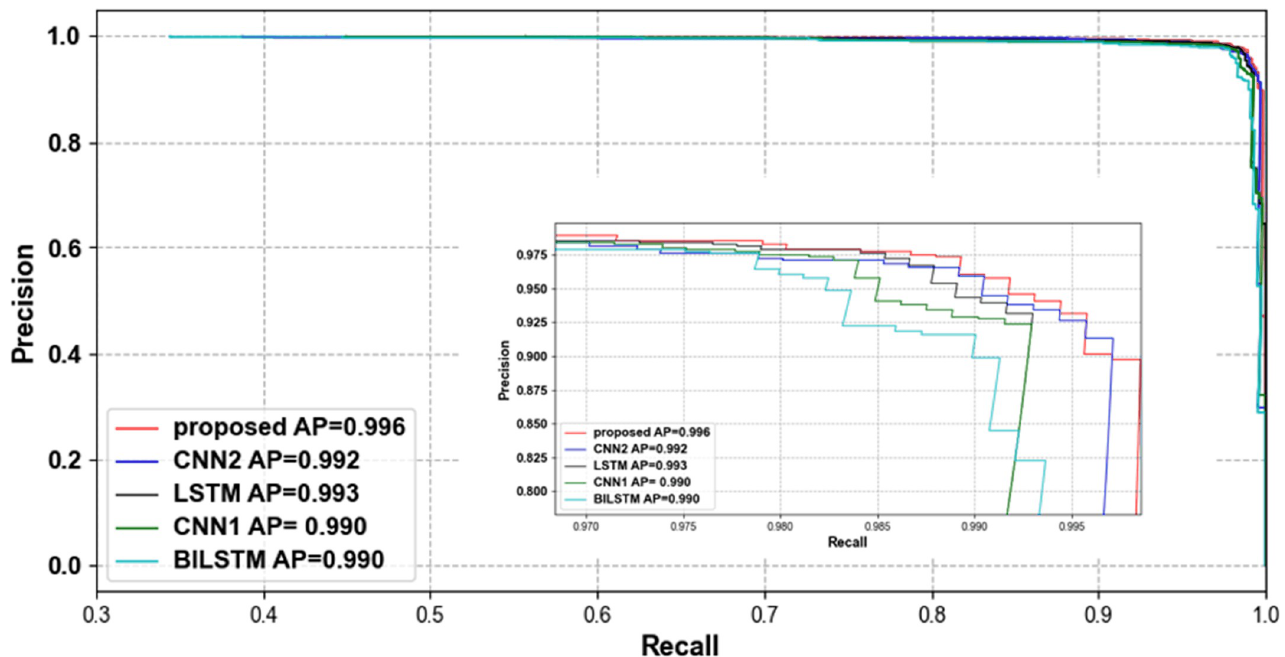
obtained from the classification under different compression ratios. Fig 15 shows the accuracy trends using different classification methods at different compression ratios. The classification method proposed in this paper also outperforms other classification methods in terms of accu- racy and is more stable for classifying data with different compression ratios under this